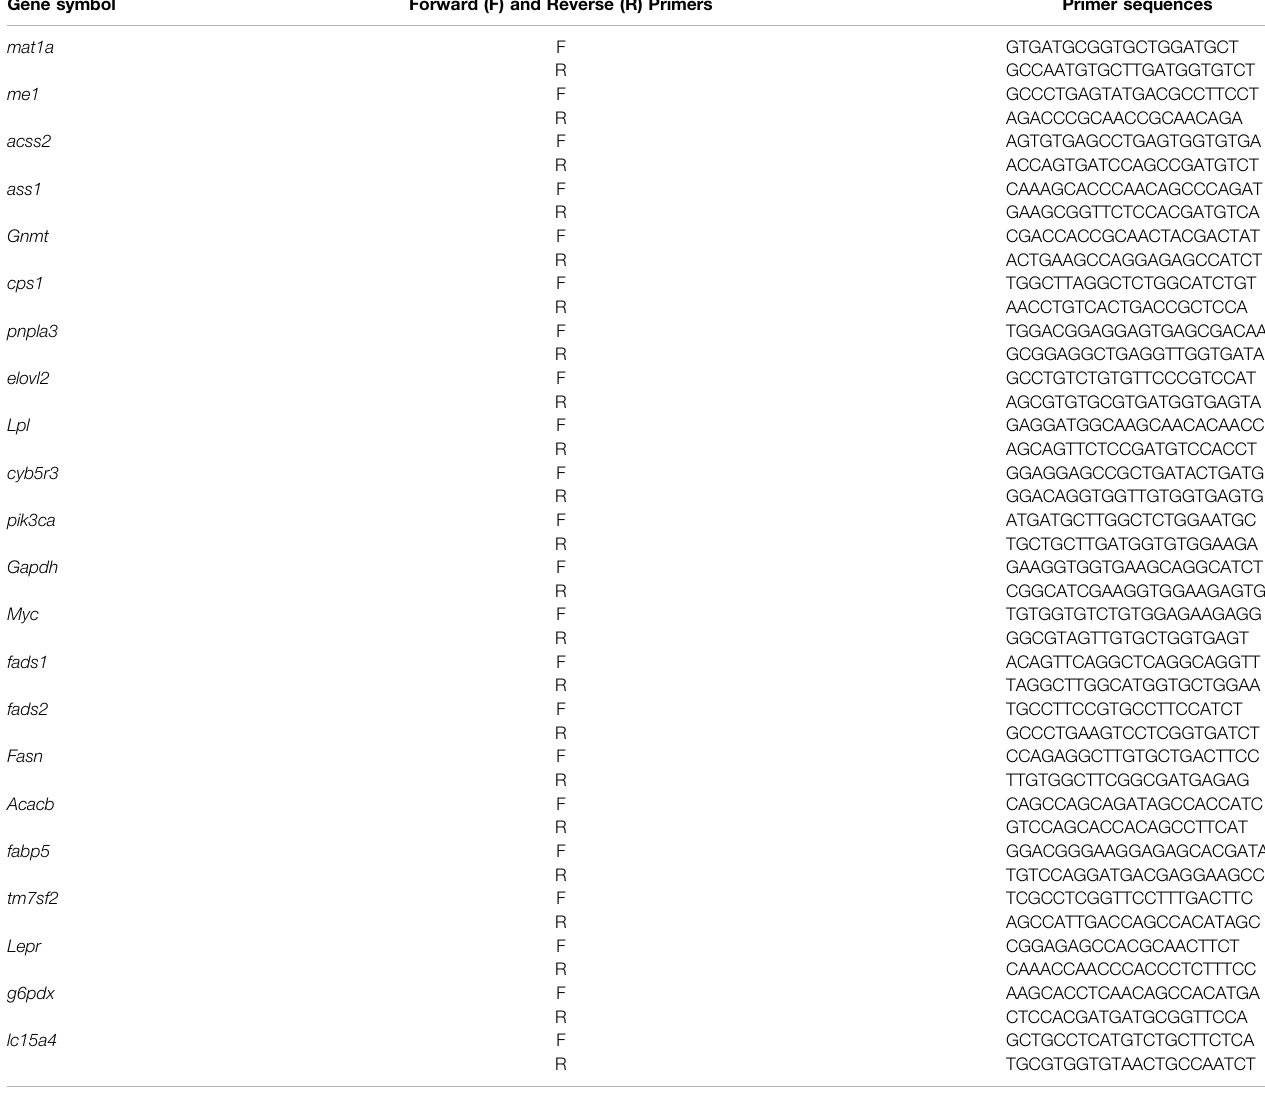
TABLE 1 | List of qRT-PCR primers. Gene symbol Forward (F) and Reverse (R)